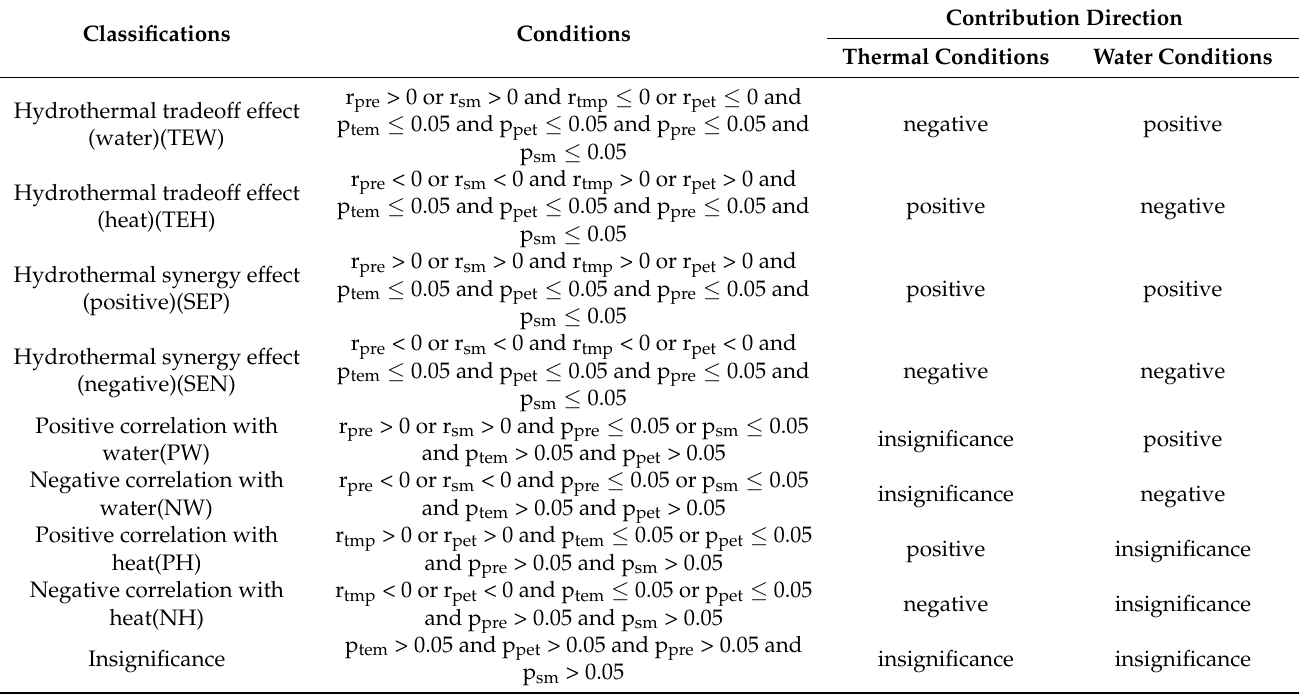
Table 3. Division of the function types of hydrothermal conditions affecting vegetation